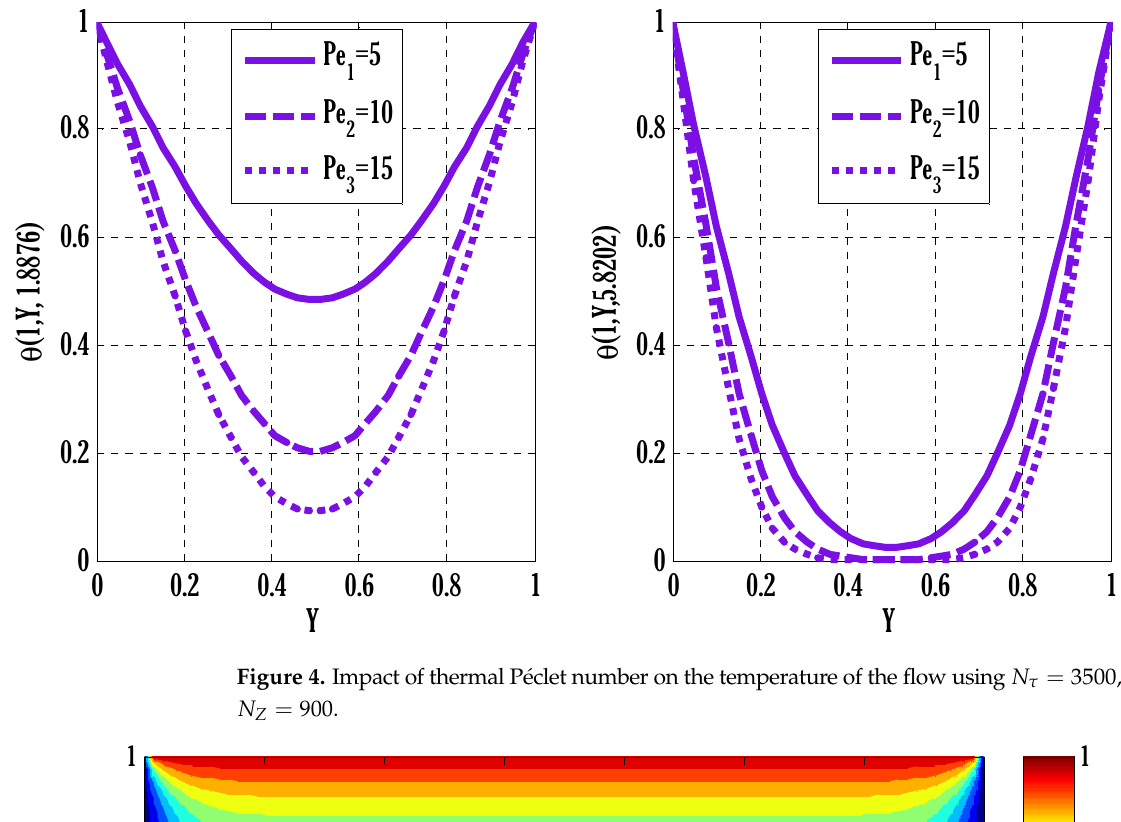
Figure 4. Impact of thermal P é clet number on the temperature of the flow using N τ = 3500, N Y = 40, N Z = 900.